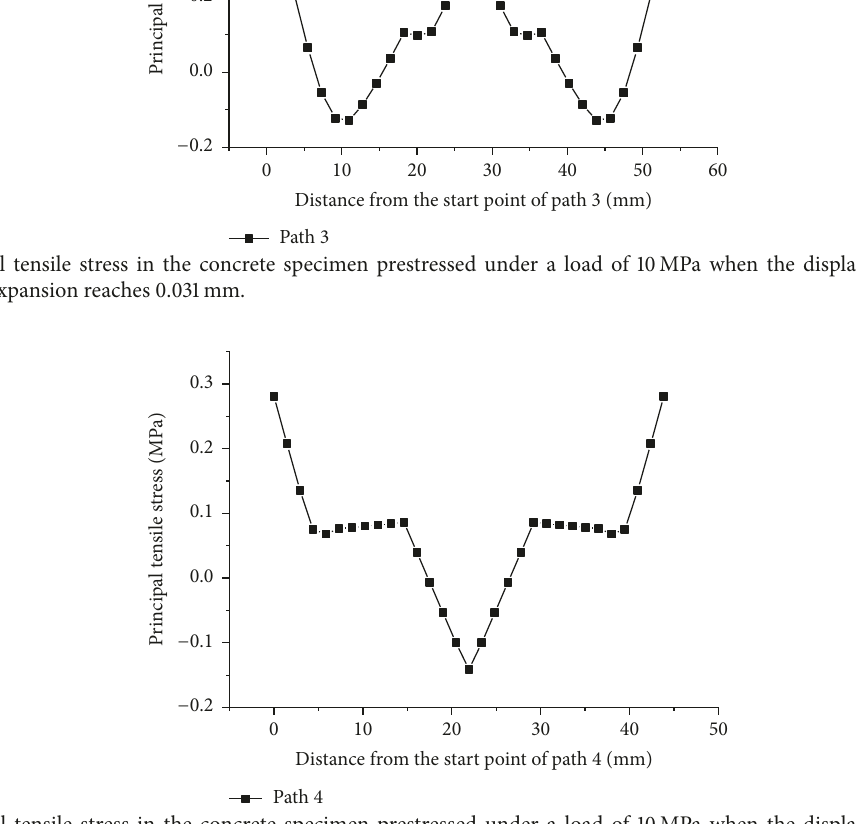
Figure 36: Principal tensile stress in the concrete specimen prestressed under a load of 10MPa when the displacement resulting from corrosion-induced expansion reaches 0.031